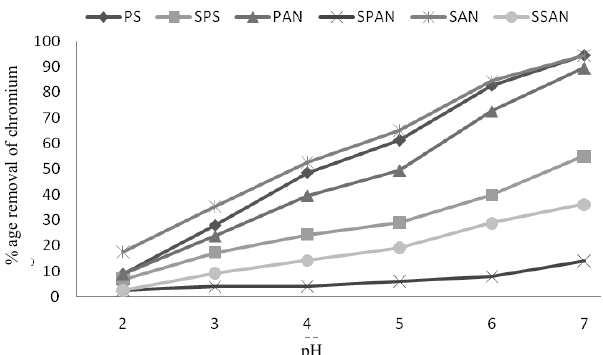
Figure 3. The effect of pH on adsorption of Cr(III) ions.